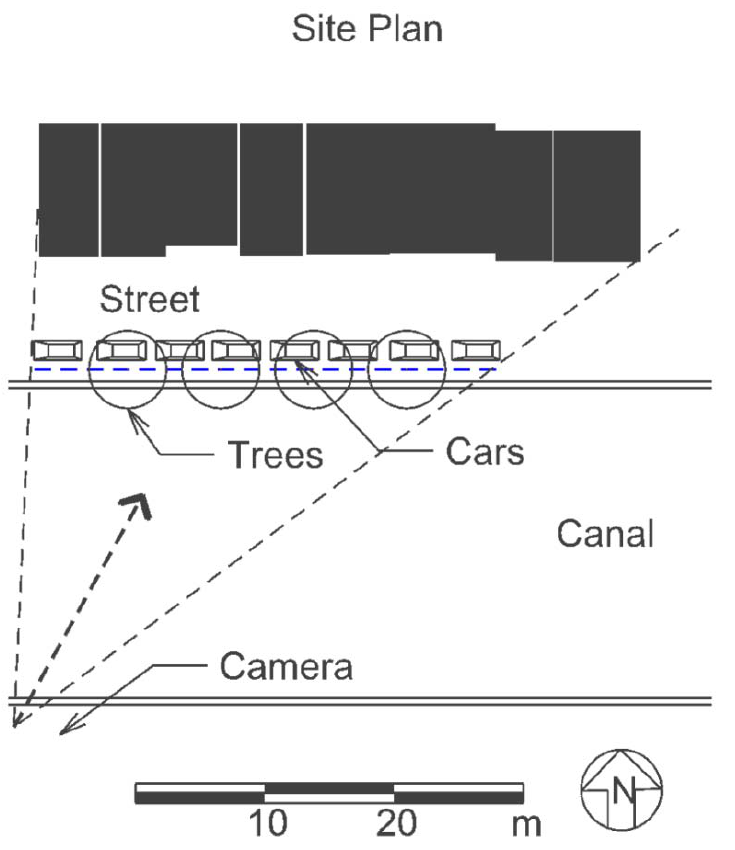
Figure 8 . Site plan for “New”